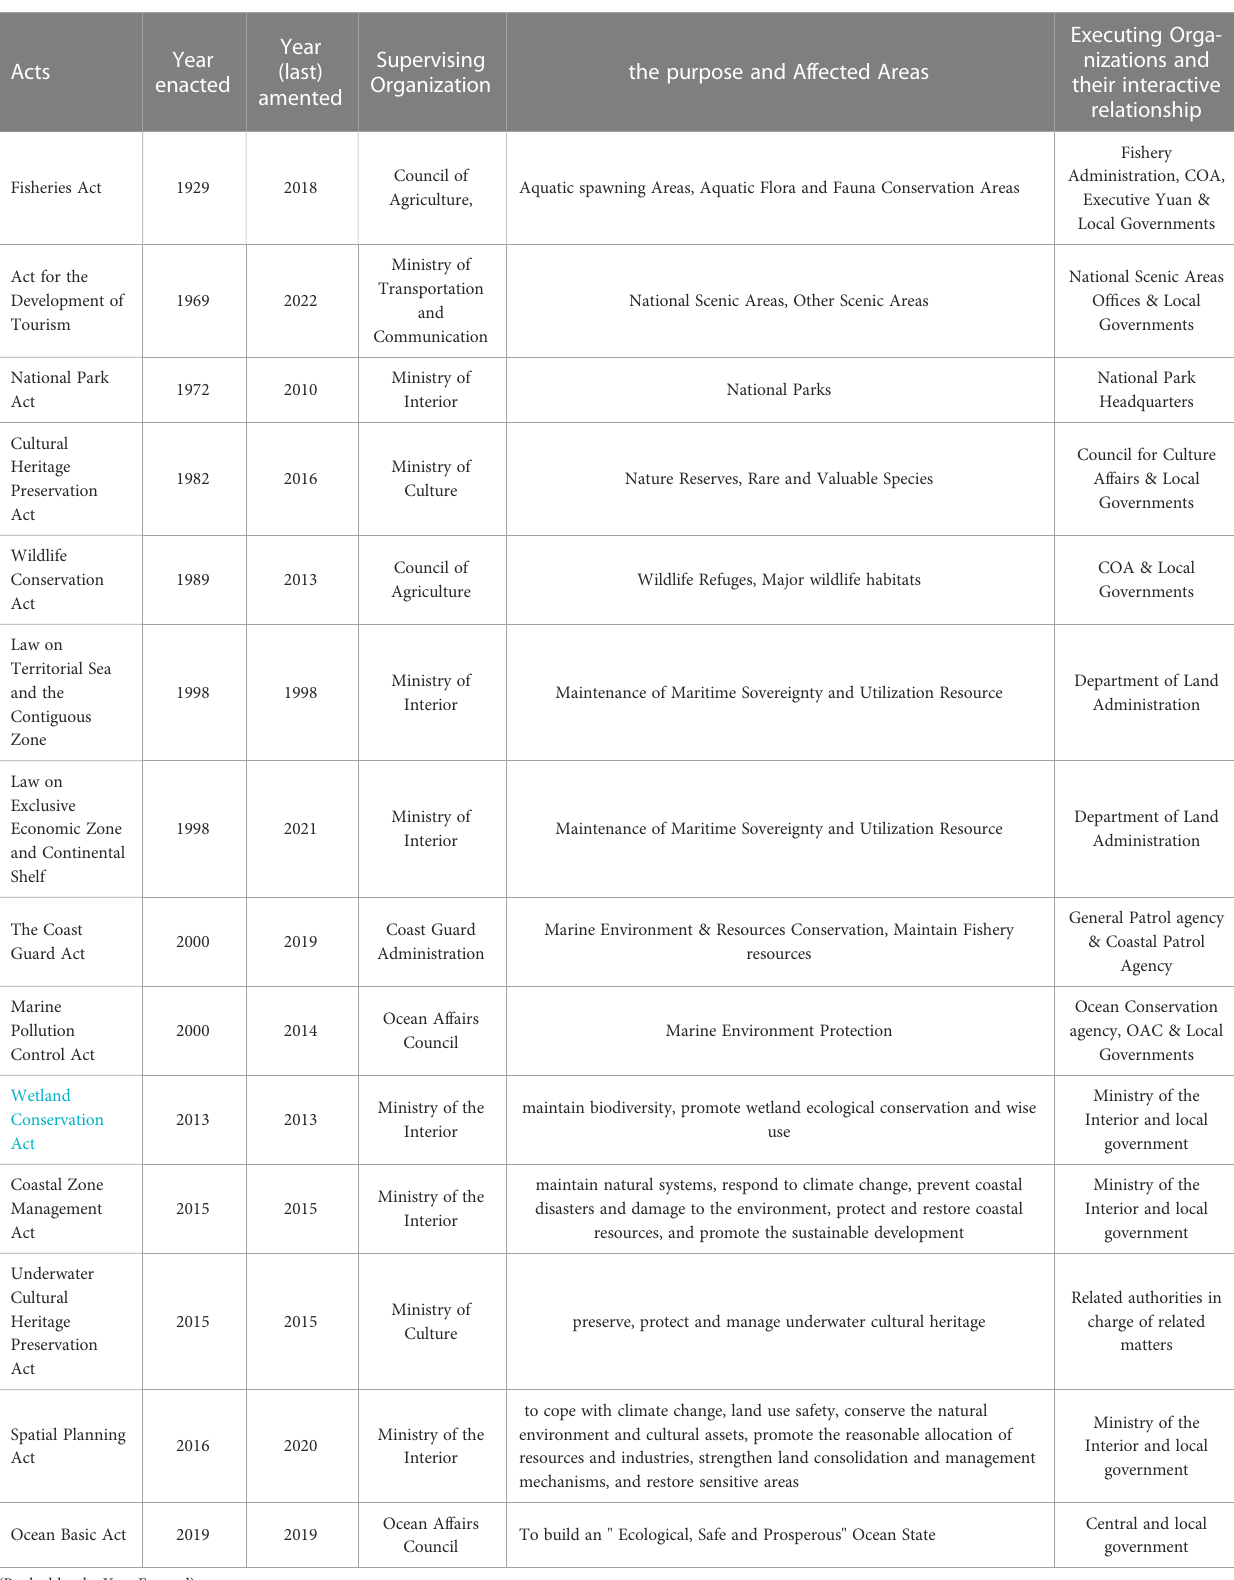
TABLE 1 The related Legislation of Taiwan for Marine Environment and Resources Conservation